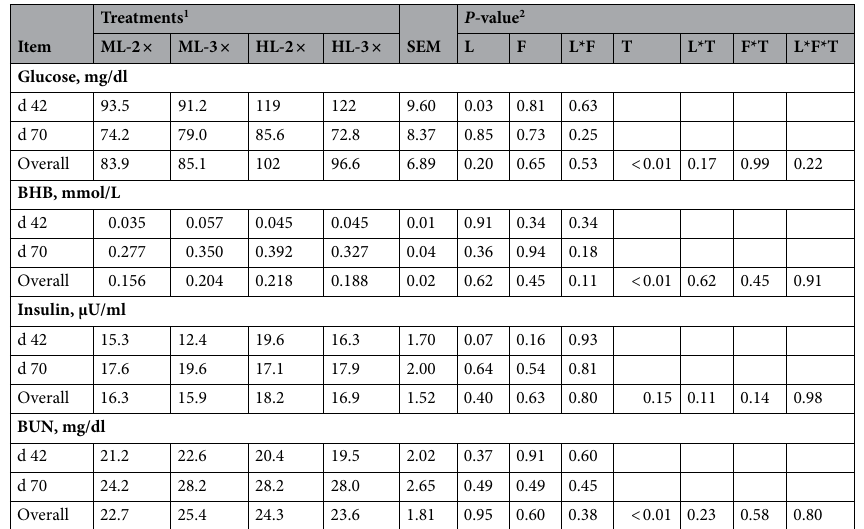
Table 4. Effects of milk feeding level (medium vs. high) and milk feeding frequency (2 vs. 3) on blood metabolites of dairy calves during days of 42, 70, and overall (n = 12 calves/treatment). 1 Treatments including medium milk level- feeding 2 times (ML-2 ×), medium milk level- feeding 3 times (ML-3 ×), high milk level- feeding 2 times (HL-2 ×), and high milk level- feeding 3 times (HL-3 ×). 2 Statistical comparisons: L = feeding level; F = feeding frequency, L × F = feeding level × feeding frequency, T = time, L × T = feeding level × time, F × T = feeding frequency × time, and L × F × T = feeding level × feeding frequency ×